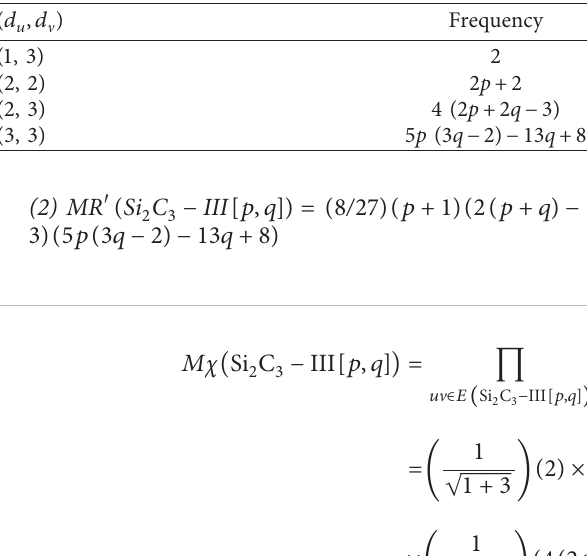
Table 3: Partition of E ( Si